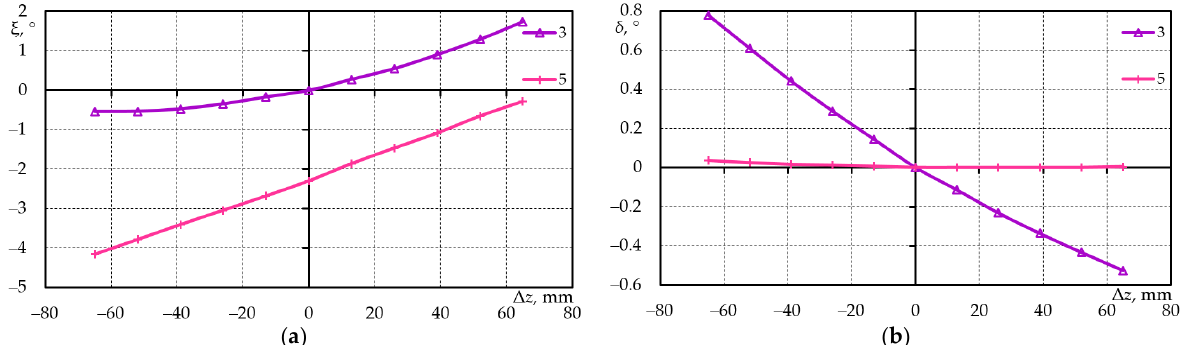
Figure 24. Dependence of transverse wheel displacement ( a ) and wheel turning angle ( b ) on vertical wheel travel (marking according to Table 2).